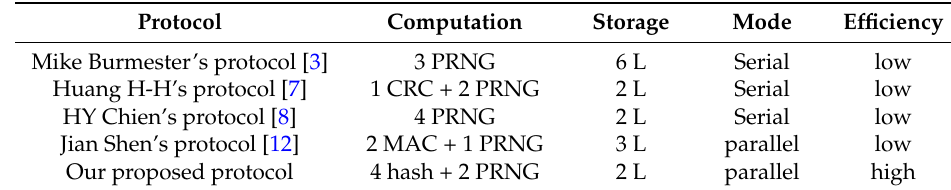
Table 2. The computation and storage requirements of the different protocols for